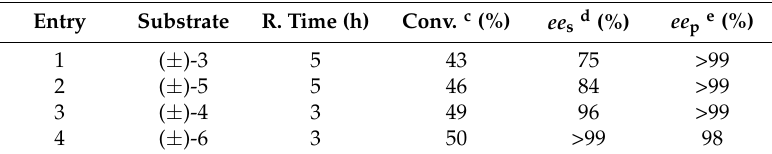
Table 2. CAL-B-catalyzed ring cleavage of racemic 3 a , 4 b , 5 a and 6 b .